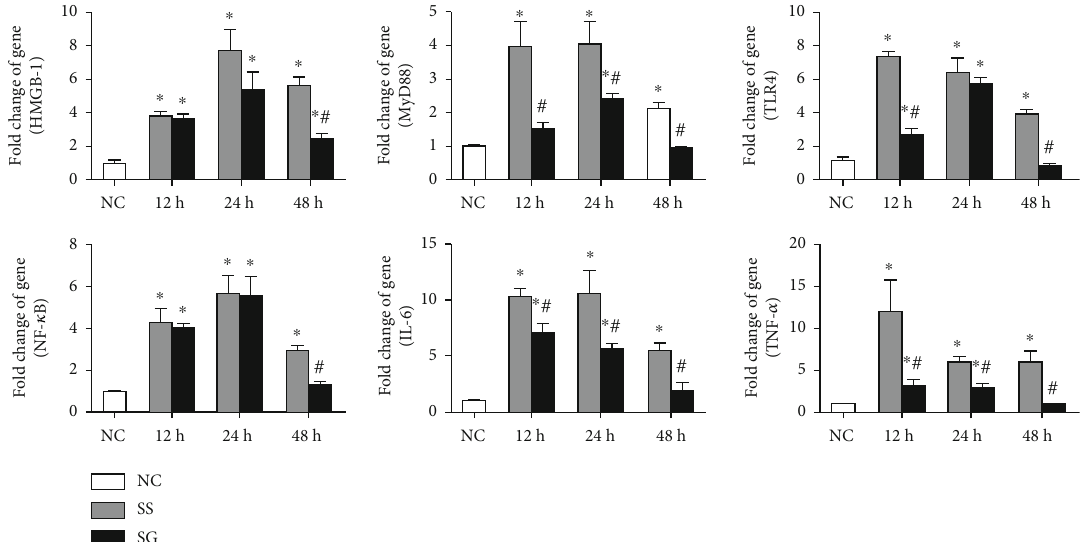
Figure 2: Messenger (m)RNA expressions of high-mobility group box protein-1 pathway-associated genes and subsequent in fl ammatory cytokines in kidney tissues. NC: normal control; SS: sepsis group with saline; SG: sepsis group with glutamine; HMGB-1: high-mobility group box protein-1; TLR4: toll-like receptor-4; NF- κ B: nuclear factor- κ B; TNF- α : tumor necrosis factor- α ; IL-6: interleukin-6. mRNA changes were quantitated and analyzed by a real-time PCR and were calculated by the comparative CT (2 - ΔΔ Ct ) method. mRNA expression levels in the normal control group were used as a calibrator. Values are expressed as the mean ± SEM . n = 8 for each group at 12, 24, and 48 h after cecal ligation and puncture (CLP). Di ff erences between 2 sepsis groups at the same time point were analyzed by t -test. The comparison among NC and the sepsis groups at three di ff erent time points were analyzed by a one-way analysis of variance (ANOVA) followed by Tukey ’ s post hoc test. ∗ Signi fi cantly di ff ers from the NC group; # signi fi cantly di ff ers from the SS group at the same time point ( p < 0 : 05